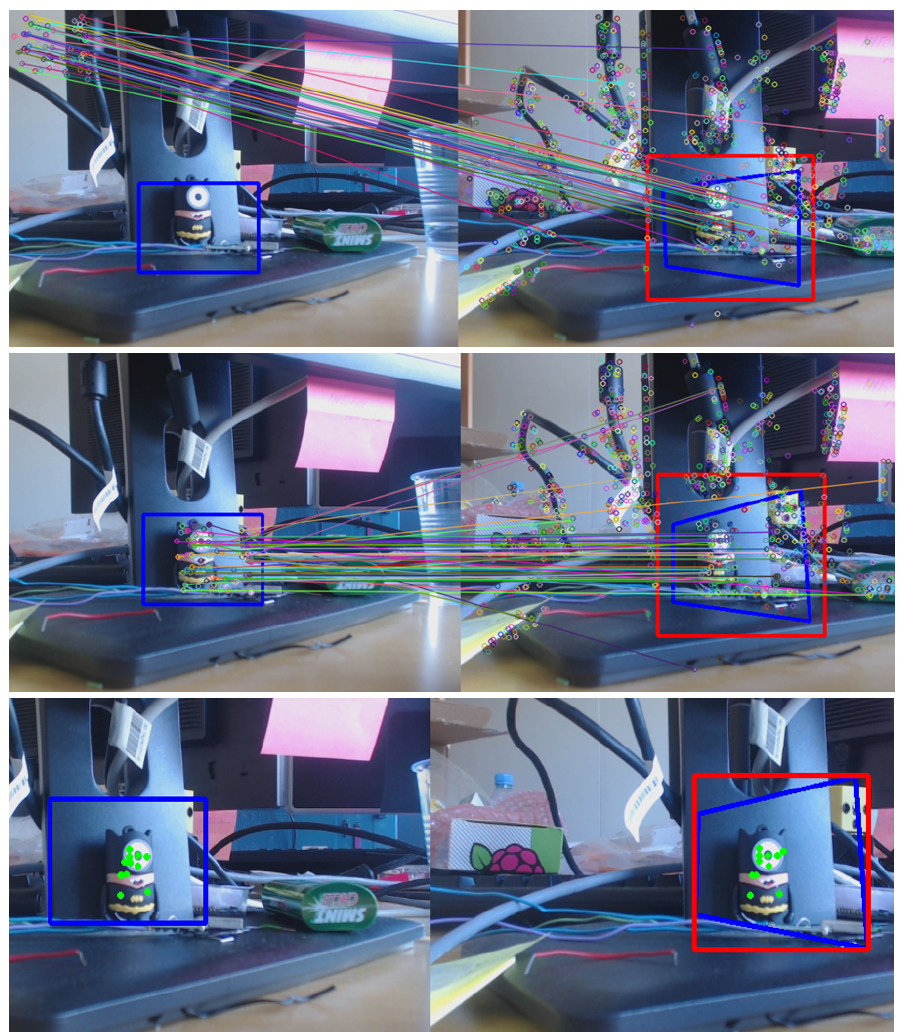
Figure 7. ( Top ) key-points correlation between two images in raw. ( Middle ) key-points correlation among two pictures after the isolated ROI (used as a pattern) translation adaptation. ( Bottom ) key-points correlations after filtering with the euclidean distance-based